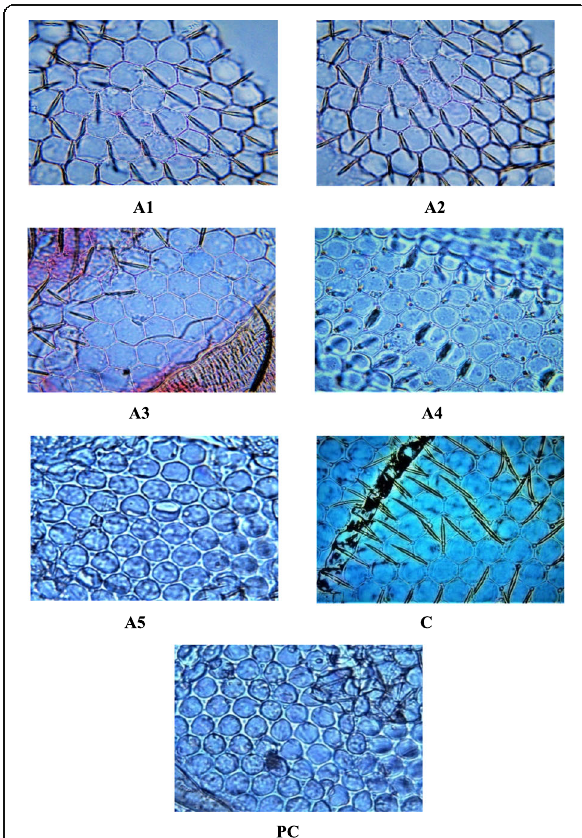
Fig. 7 Eye surface of the emerged flies from the larvae exposed to various doses of arecoline, (A1 = 5 μ M arecoline, A2 = 10 μ M arecoline, A3 = 20 μ M arecoline, A4 = 40 μ M arecoline, A5 = 80 μ M arecoline, C = Control, PC (Positive Control) = 10 μ l/ml methyl